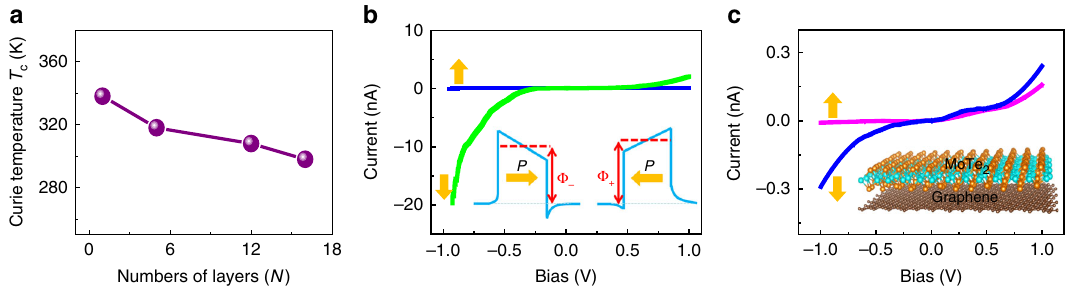
Fig. 4 T c of d 1T-MoTe 2 and FTJ devices. a Layer-dependent T c of d 1T-MoTe 2 . b I – V characteristic of monolayer d 1T-MoTe 2 on Pt and inset shows the energy diagram of FTJ devices. c I – V characteristic of few-layer d 1T-MoTe 2 on graphene and inset shows the schematic of